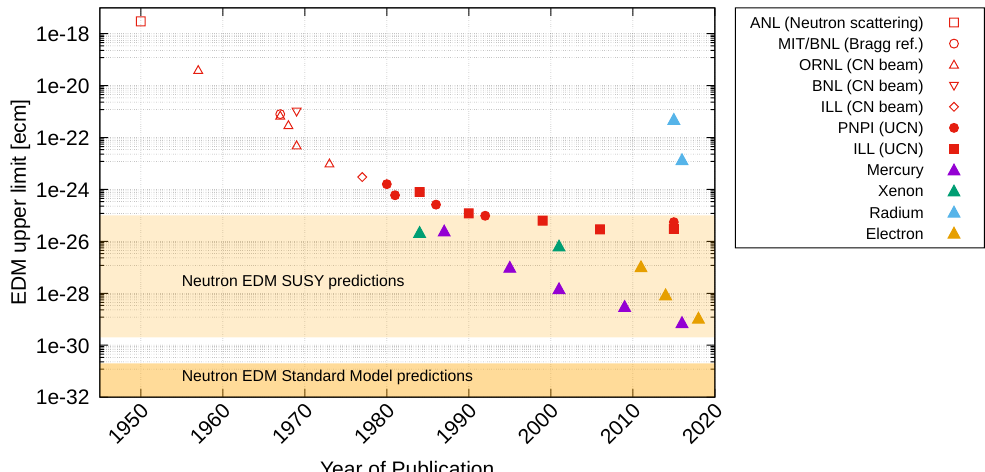
Figure 2. Experimental progress of EDM searches showing published upper limits for the neutron, the electron and atoms. Tremendous improvements on sensitivities have been achieved from early neutron beam to modern ultra cold neutron storage experiments. The superior EDM measurement with the highest sensitivity was conducted using the diamagnetic atom 199 Hg. Recent remarkable results come from electron EDM searches, using highly polarizable molecules. An example of a new candidate is the 225 Ra EDM experiment using trapped atoms with heavy